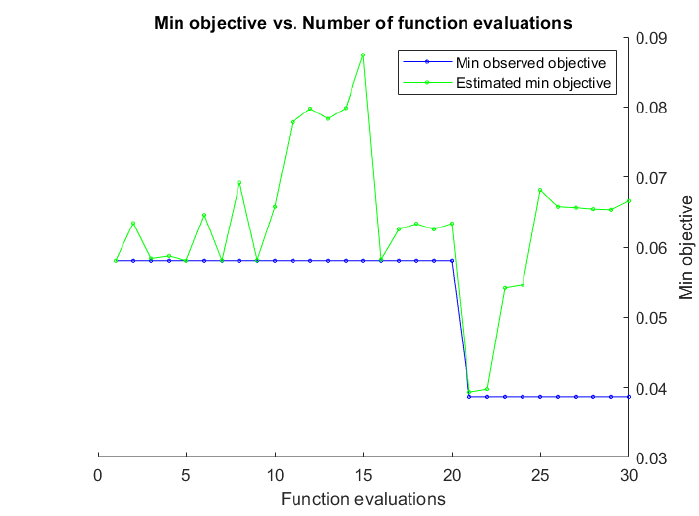
Figure 8. Objective function values throughout the optimization iterations of Experiment 1. Table 3. Objective function evaluations and corresponding optimization variable estimates of the proposed CNN trained by fundus retinal images in Experiment 1. Entries of the optimal model are highlighted in bold